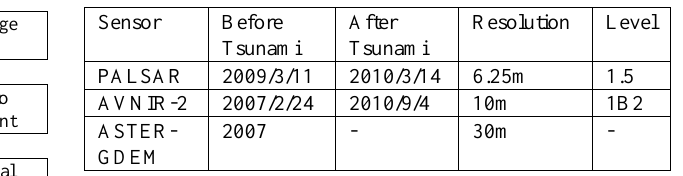
Table 1. List of satellite data used in the